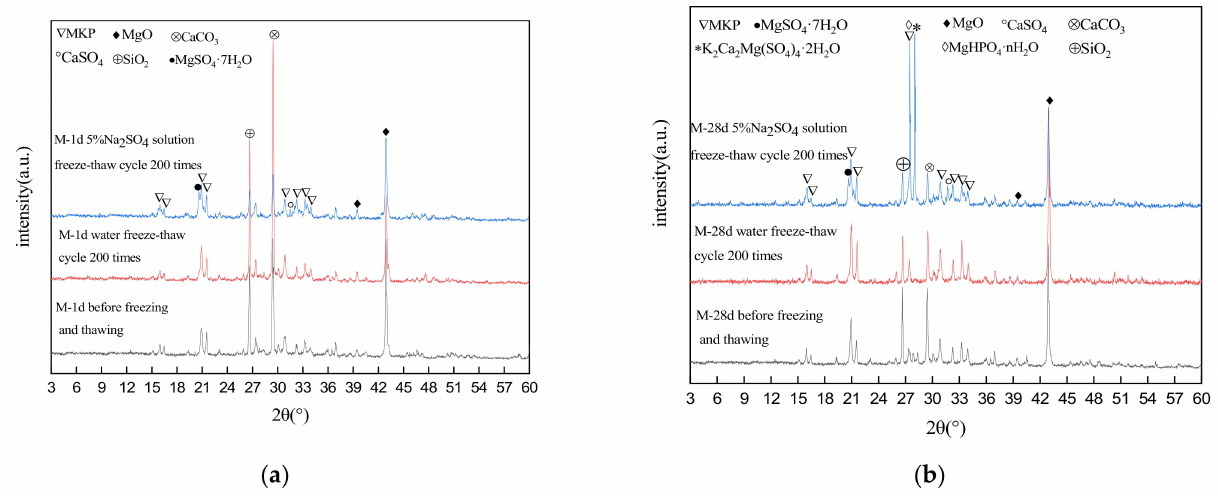
Figure 7. XRD patterns of MKPC mortar samples. ( a ) M-1d; ( b )